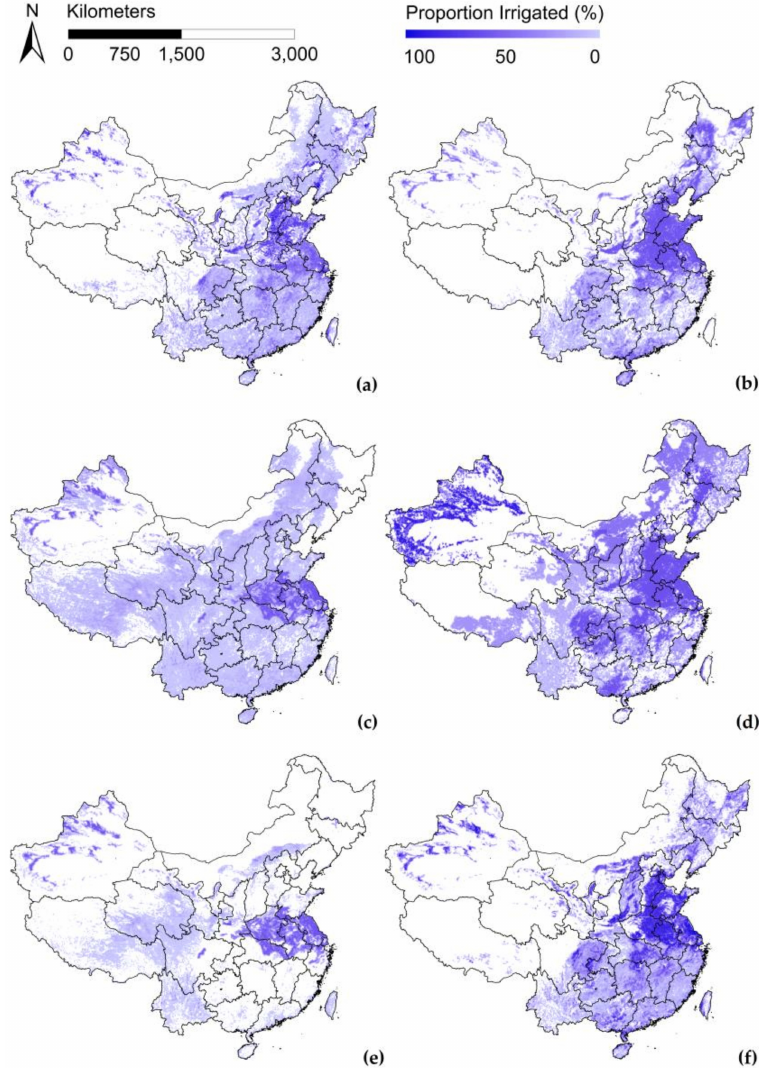
Figure 1. Four irrigated croplandmaps. ( a ) GMIA ( b ) GRIPC ( c ) Glob05 ( d ) GFSAD ( e ) Glob05 without mosic cropland pixels (f) GFSAD without mosaic cropland